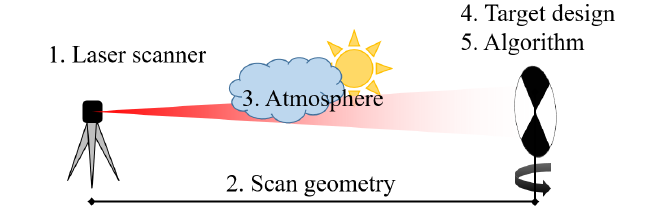
Figure 2. Influencing factors on the precision of the target center estimation